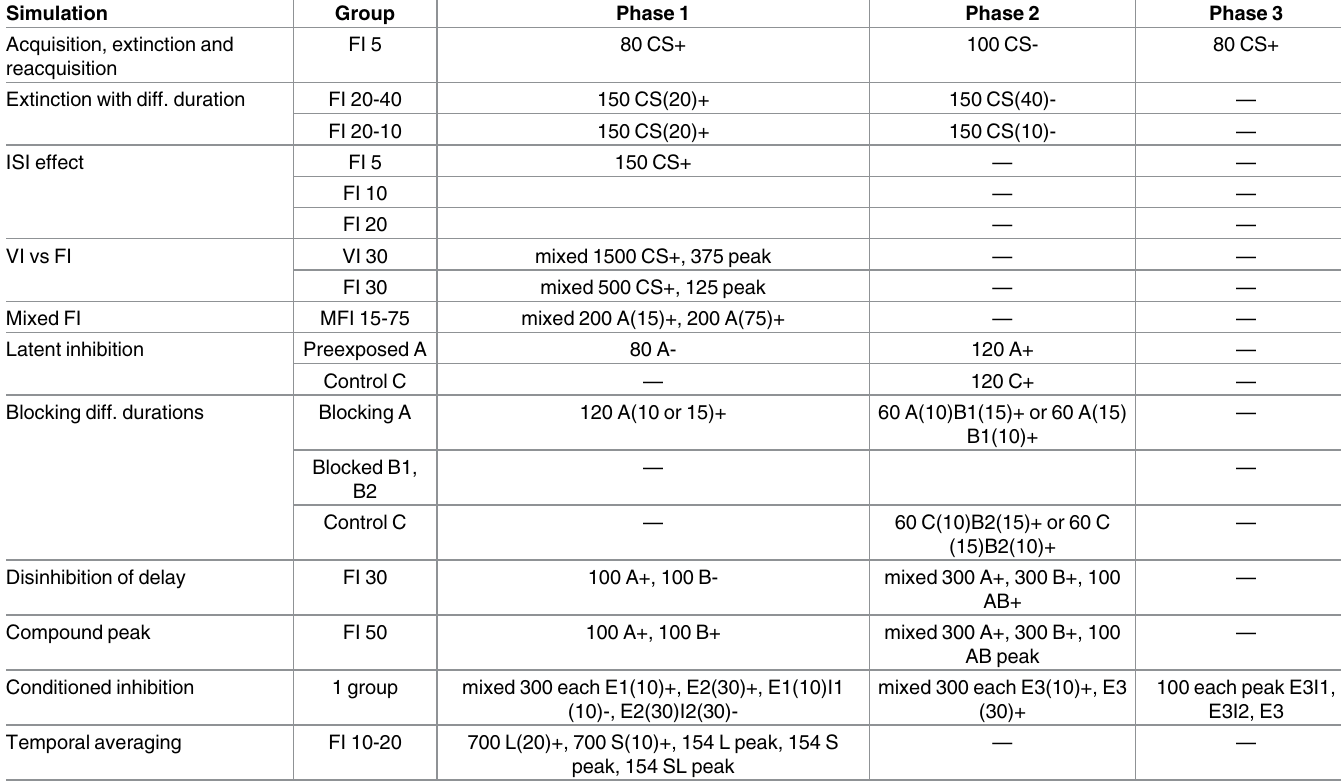
Table 3. Simulation